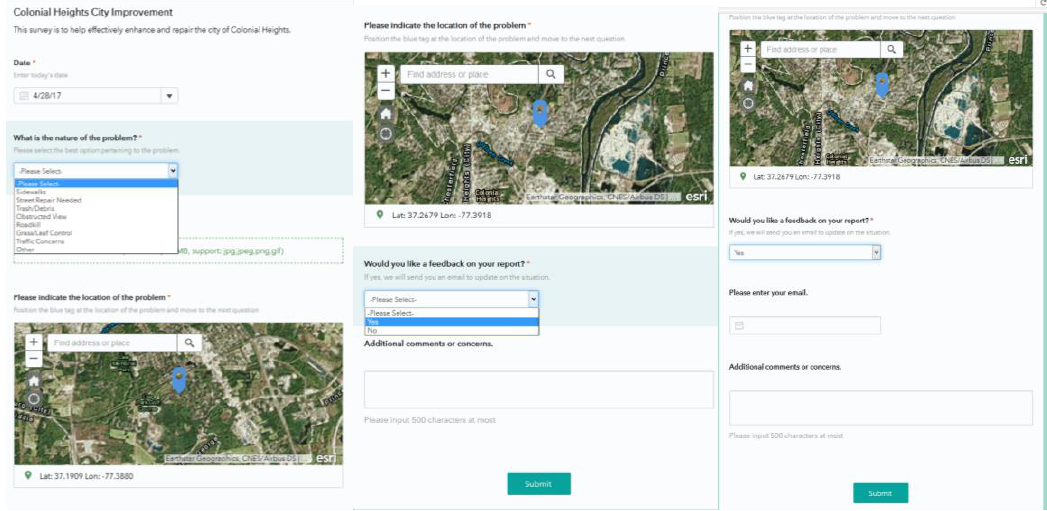
Figure 7. City Improvement Report Form (Three screens) (https://survey123.arcgis.com/share/ 5174bcc151d141b78ed442c58a4a0dff).